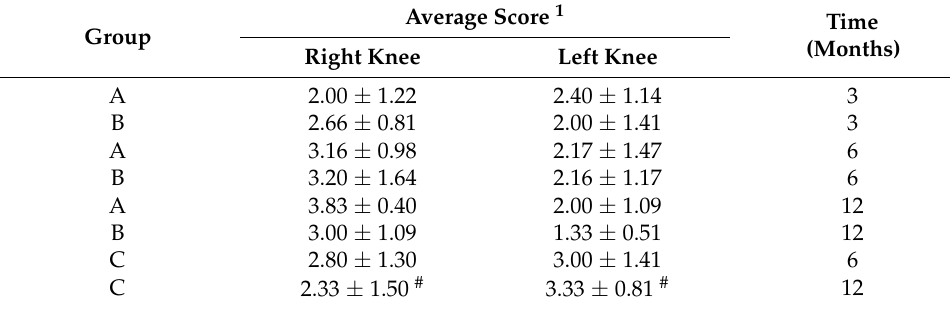
Table 2. Macroscopic evaluation; Indium ink method.